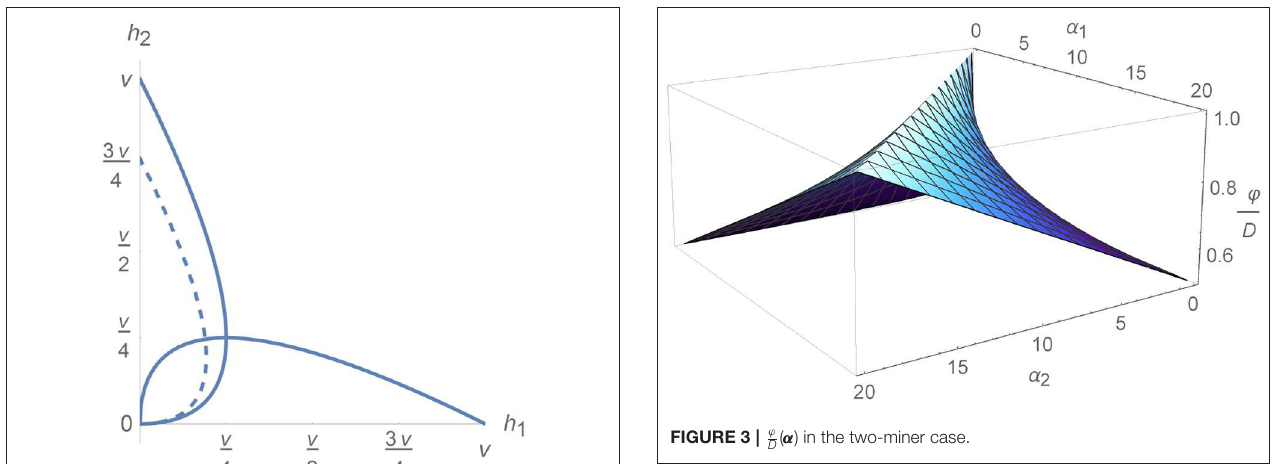
FIGURE 2 | Reaction curves from (11) with α 1 (dashed).